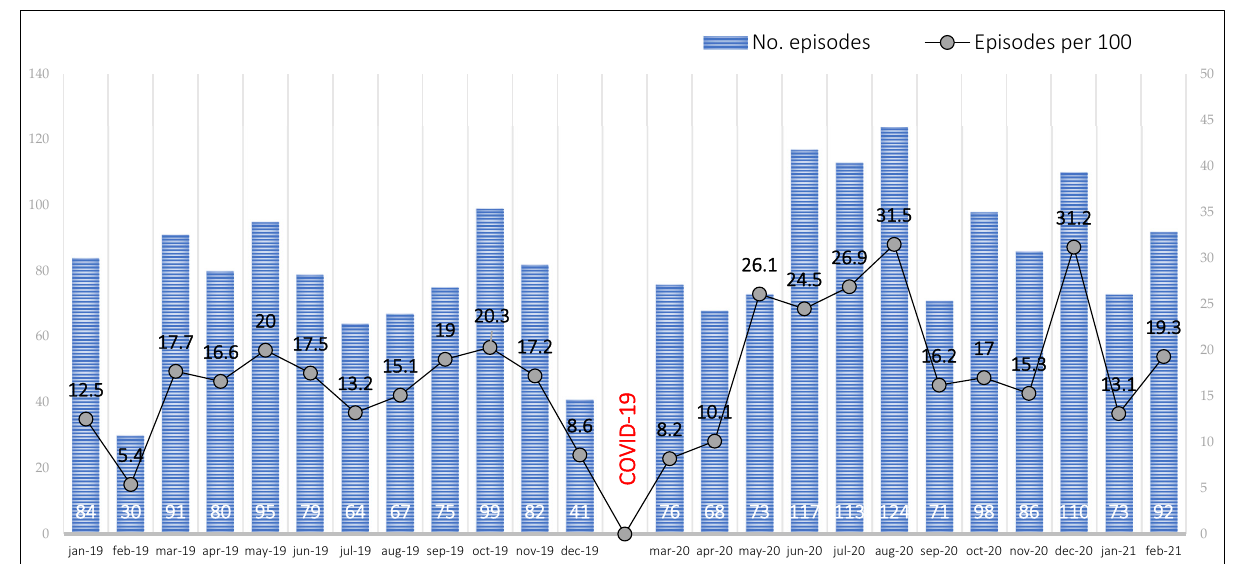
Figure 2. Temporal evolution of skin wound episodes before (pre-pandemic year, 2019) and during the first year of the COVID-19 pandemic in Internal Medicine Units, Salamanca (Spain). Figure 3 illustrates the monthly comparison of wound episodes recorded in patients with COVID-19 and non-COVID-19 diagnoses during the first year of the pandemic. We observed a significant increase in the percentage of wound episodes in patients with a